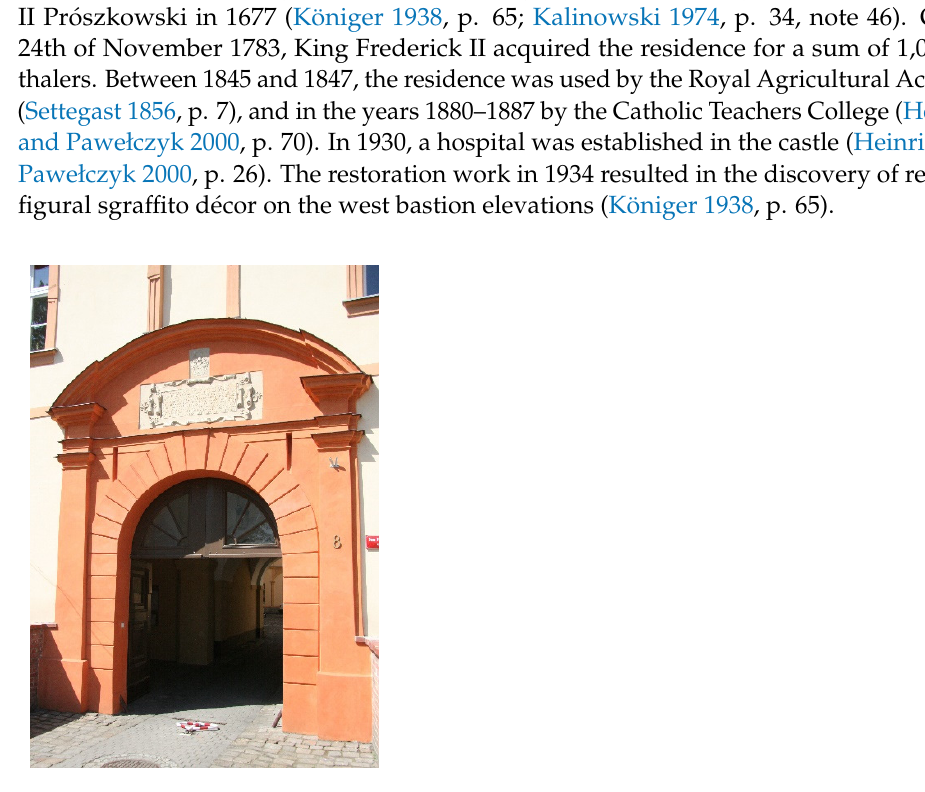
Figure 2. Prószków castle: the inscription board is above the entrance; photo by the authors. Figure 2. Pr ó szk ó w castle: the inscription board is above the entrance; photo by the